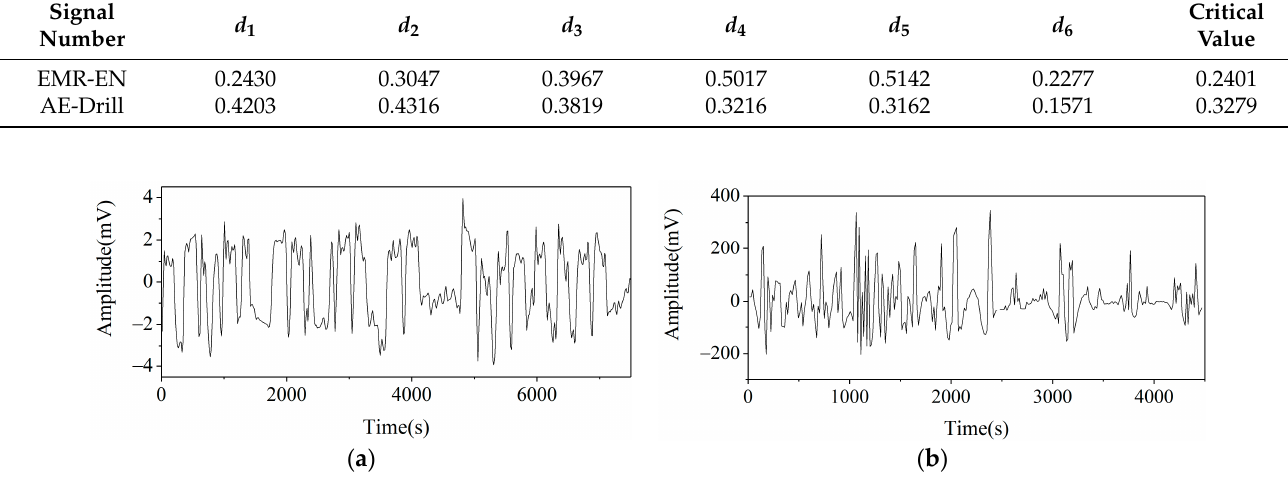
Figure 7. Reconstructed signals. ( a ) EMR signal. ( b ) AE